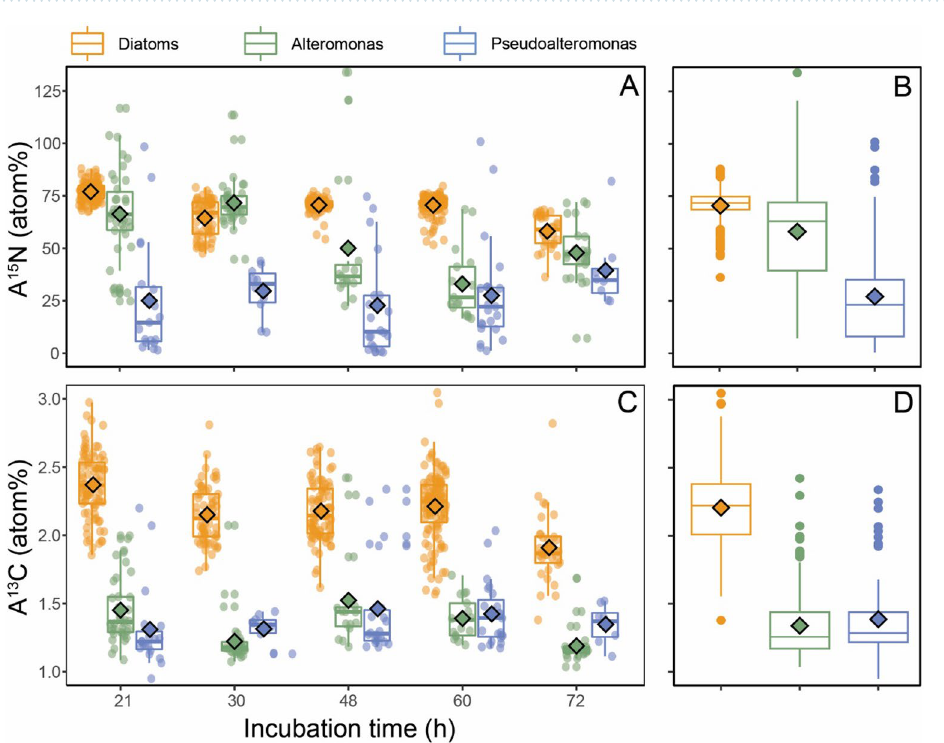
Figure 3. ( A , C ) 15 N and 13 C isotopic enrichment (atom%) of the diatom L. danicus and bacteria Alteromonas and Pseudoalteromonas combining both, attached and non-attached fractions, as a function of time. Each circular dot represents an analyzed cell (total cells analyzed 621: 131 Alteromonas, 82 Pseudoalteromonas and 407 diatoms) and larger dots represent groups average at each time point. ( B , D ) Whisker plots of the 15 N and 13 C isotopic enrichments for each group analyzed (as average for all times points